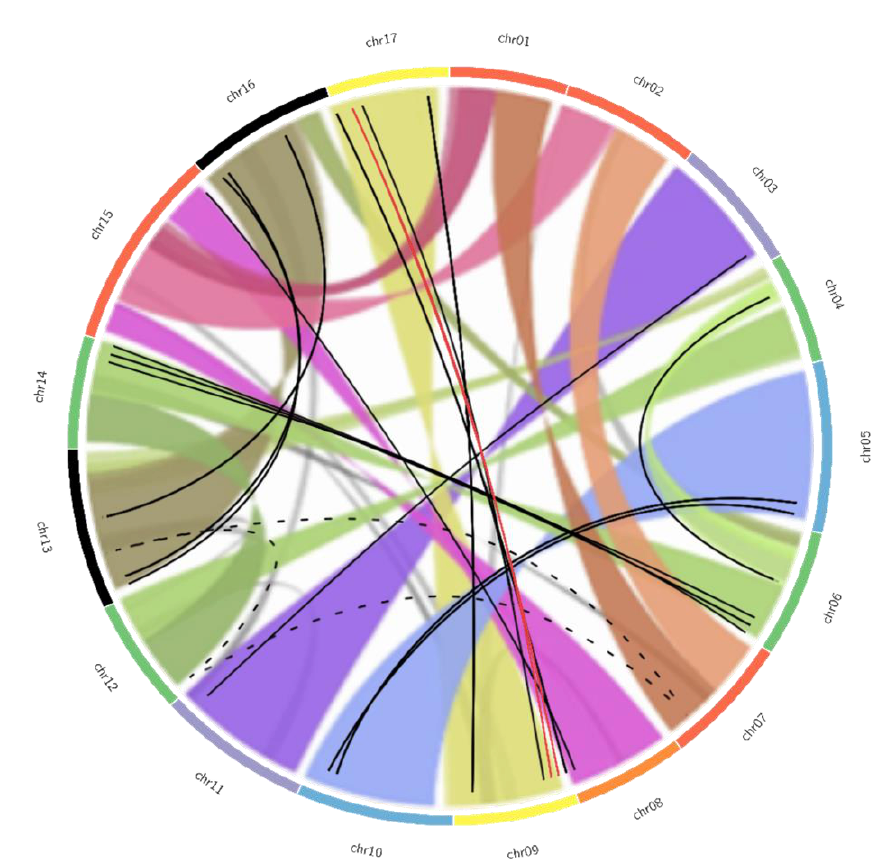
Figure 3. Graphical representation of the duplication pattern observed in MdTCP genes overlapped to pattern of chromosome duplication observed in the Apple genome. The pattern of apple genome duplication, as determined by Daccord and colleagues [17], is indicated as colored ribbons connecting homologous regions between the chromosomes, as represented by the colored slim boxes on the outside of the circle. Similar chromosomes are indicated with the same color to help visualization. Lines connect the physical positions on the chromosomes of the potentially duplicated MdTCPs in accordance with the previous analysis: the black solid lines link the couples, the red lines link the members of the group of three, while the black dotted lines connect members of the group of four. Adapted from Daccord et al., 2019 [17], under CC BY 4.0 license.